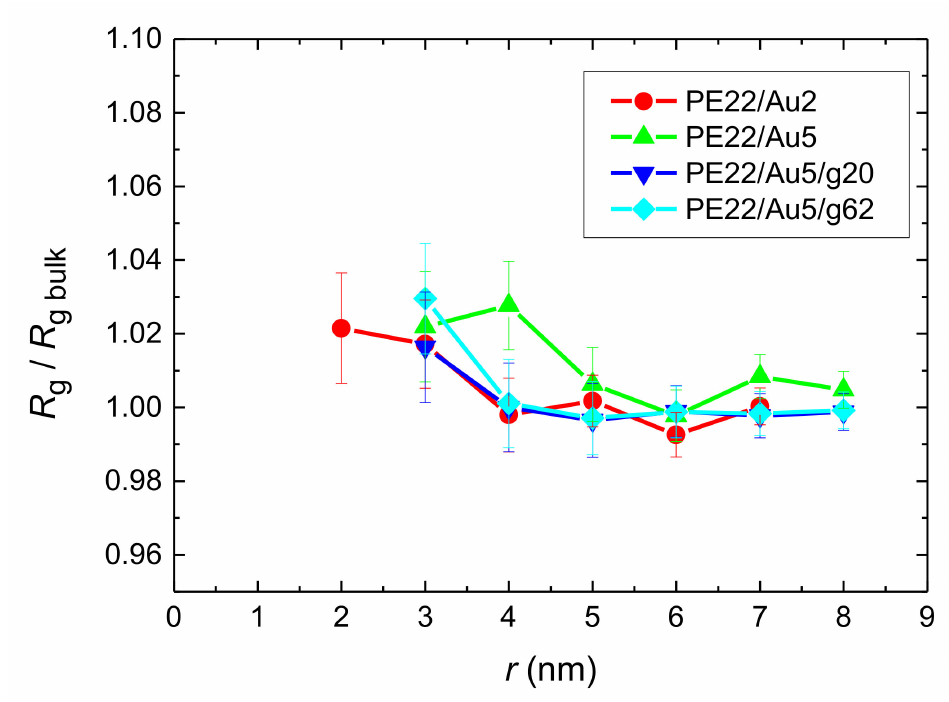
Figure A4. Radius of gyration of PE chains, scaled with its bulk value ( R g/ R g bulk ) as a function of r distance from the center of the Au NP. Data for the PE22, PE22/Au2, PE22/Au5, PE22/Au5/g20 and PE22/Au5/g62 systems are